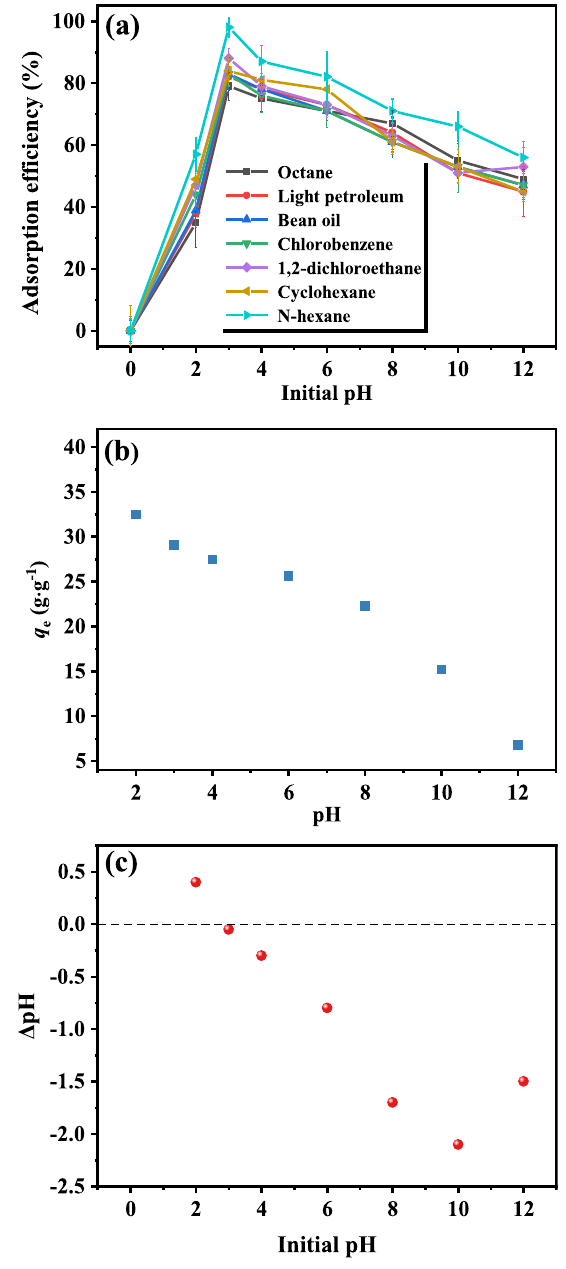
Fig. 7 Effect of initial pH on adsorption ( a ) and n -hexane adsorption capacities (q e ) of BC/PU-5 foam composites ( b ) (initial OSs concen- tration = 100 mg·L −1 , BC/PU-5 dosage = 1 g·L −1 , reaction tempera- ture = 298 K, adsorption time = 2 h) and PZC analysis of BC/PU-5 ( c